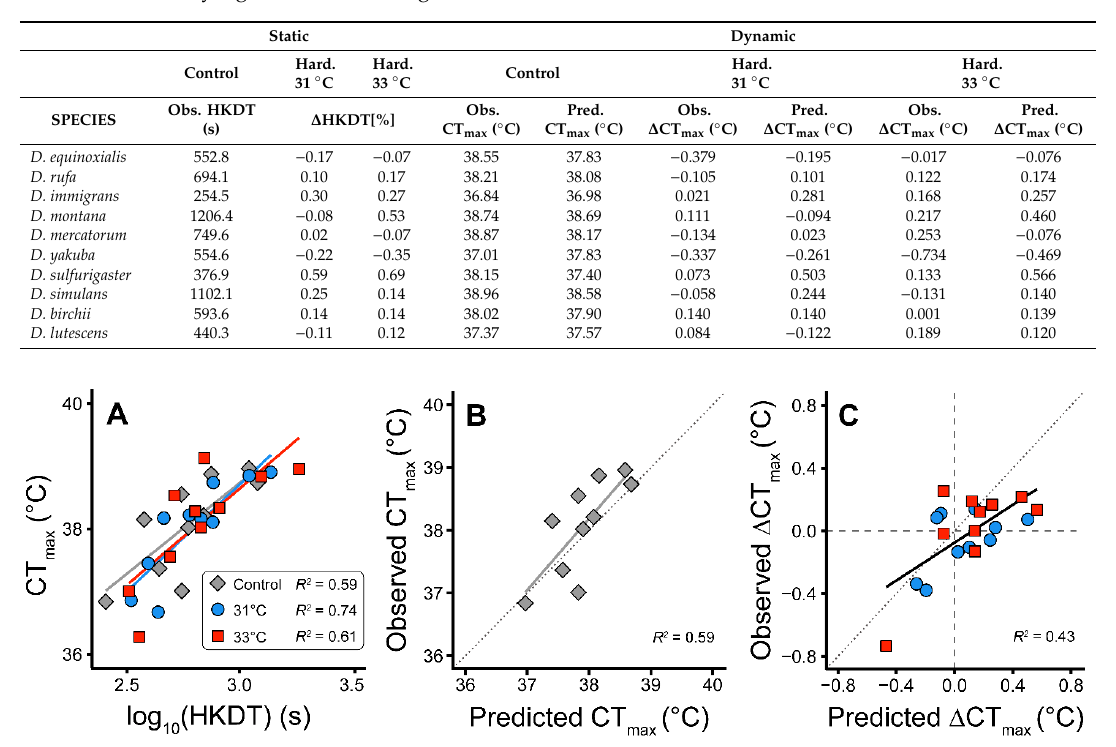
Figure 2. Comparison of static and dynamic heat tolerance measurements in 10 species of Drosophila . ( A ) Relationship between the logarithm of HKDT(s) from static tests and dynamic measures of CT max (°C). Data for each species are recorded from control and two hardening treatment groups (Table 2). For each treatment, the coefficient of determination R 2 of linear regressions are displayed in the figure and all slopes were significantly different from 0 ( p < 0.01). Treatment did not affect the slope and intercept of the linear regression between the two measures of heat tolerance (no significant interaction term or single effect of treatment). ( B ) CT max in a dynamic assay was predicted mathematically for the 10 species using data from the static experiments. The positive and significant correlation between the predicted and measured CT max (full line, R 2 : 0.59, p = 0.009) was not significantly different from the dotted line of unity ( p = 0.559). ( C ) The predicted change in CT max with hardening (predicted ∆CT max ) was modeled from the hardening responses observed in the static assay and regressed against the observed change in CT max following hardening (observed ∆CT max ) (black line, see main text and Table 2). The R 2 value of this linear regression is 0.43 and the slope is significantly different from both 0 ( p < 0.01) and 1 ( p = 0.026) while the intercept is not different from 0 (p = 0.106). The dotted line represents the line of unity.